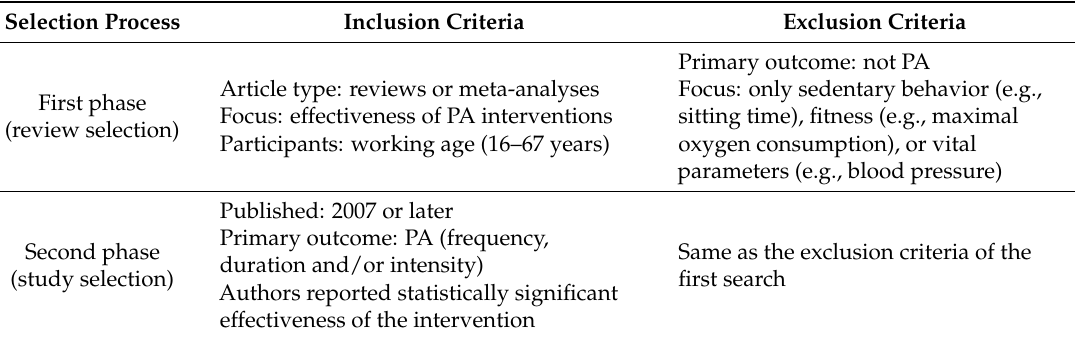
Table 1. Eligibility criteria for the literature search. PA: physical